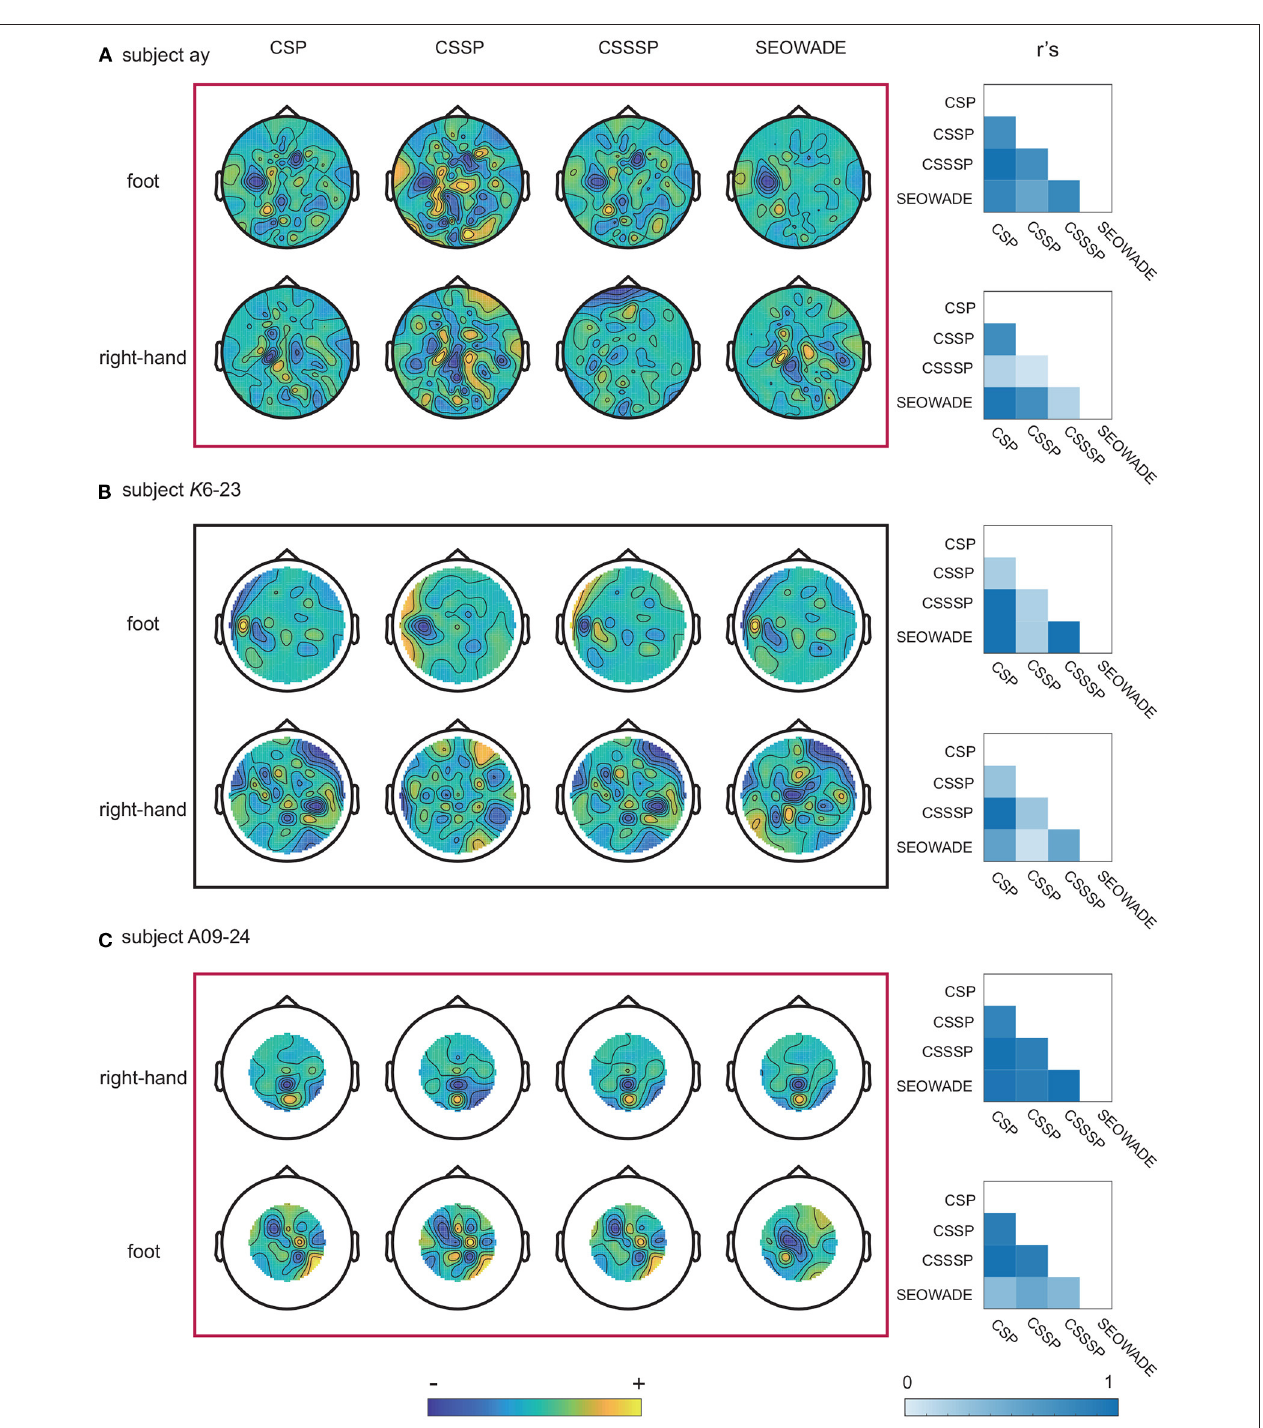
FIGURE 6 | Scalp weight maps of the optimized spatial filters (corresponding to the leading eigenvalues of each class) optimized by CSP, CSSP, CSSSP, and SEOWADE for the three representative subjects, and the absolute value r ’s of correlation coefficients between the spatial weight maps from different algorithms: (A) ay , with the performed motor imagery tasks are right-hand vs. foot; (B) K 6-23, with the performed motor imagery tasks are right-hand vs. foot; and (C) A 09-24, with the performed motor imagery tasks are right-hand vs. tongue.